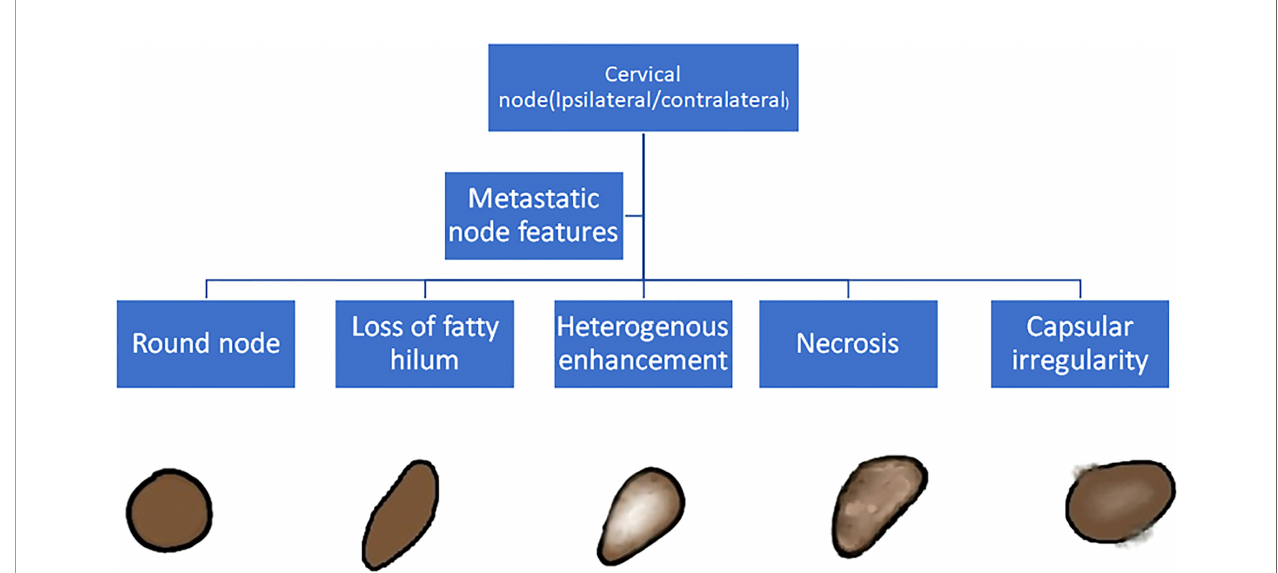
FIGURE 2 | Criteria to classify a node as metastatic: Round node, loss of fatty hilum, heterogeneous enhancement, necrosis, and capsular irregularity. Node with any 2 or more positive features was considered